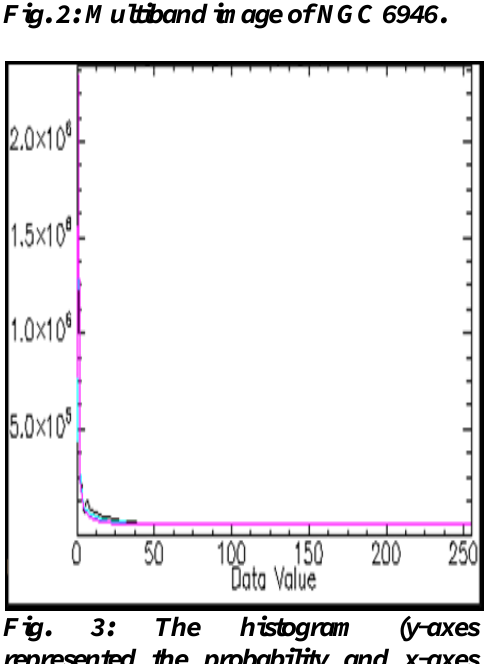
Fig. 4:The classified image of NGC 6946 .